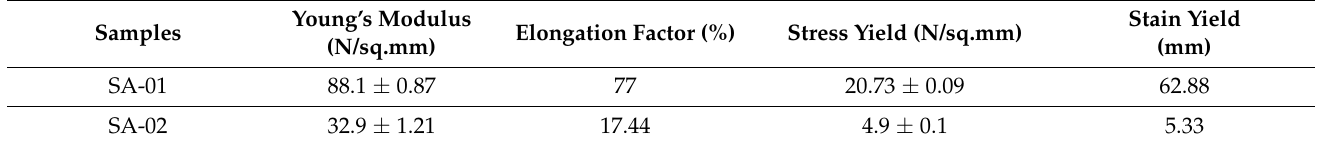
Table 3. Tensile strengths and Young’s moduli of sulfonated PEEK samples with different degrees of